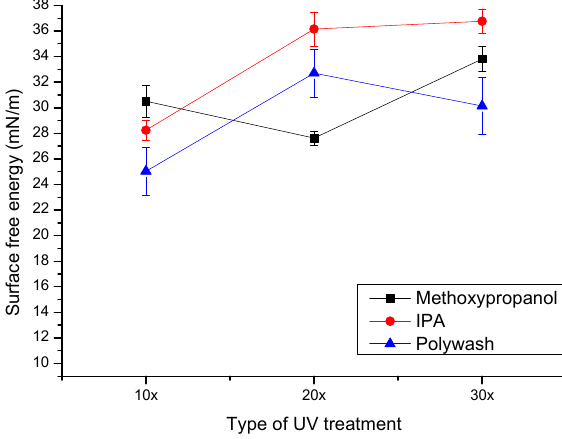
Figure 6. Surface free energy of the modified photopolymer printing plate samples after exposure to solvents.